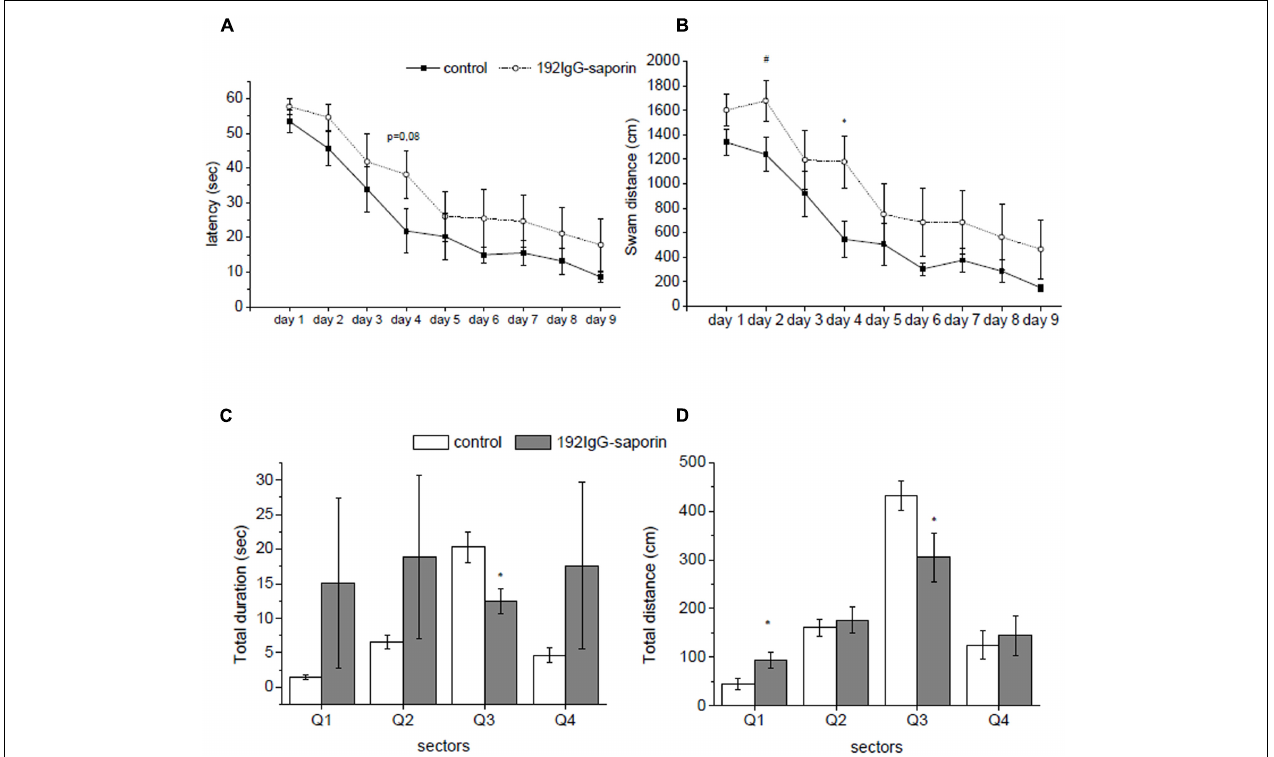
FIGURE 1 | The effects of intraventricular injection of 192 IgG-saporin (Ig-saporin) on spatial memory in Morris water maze task. Ig-saporin injected rats ( n = 8) had longer latencies to reach the platform (seconds) (A) and higher distance swam (centimeter) (B) compared to control ( n = 8) during the 9 days when the animals learned to find platform. On day 10 of testing, during probe trial saporin-treated rats ( n = 8) spent significantly less time in a quadrant, where the platform was during training (C) , and swam shorter distance in it compared to the control ( n = 8) (D) . Each point represents the mean ± SEM, ∗ P <